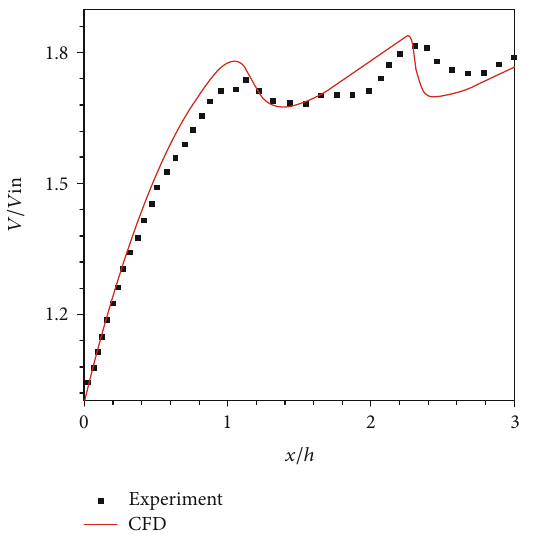
Figure 9: Dimensionless velocity distributions at the centerline obtained from the CFD model and experiment.